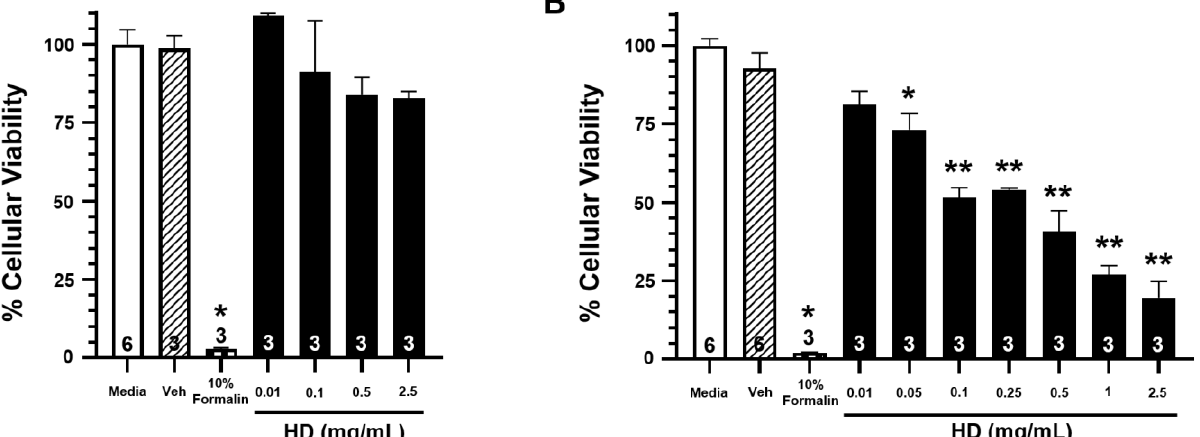
Figure 2. Effects of HD on the viability of EpiAirway TM tissues. Open bars represent mean ± SEM of cellular viability of untreated EpiAirway TM tissues at 3 h ( A ) or 24 h ( B ).Closed bars represent mean ± SEM of cellular viability of EpiAirway TM tissues at 3 h ( A ) or 24 h ( B ) following treatment with increasing concentrations of HD (0.01 – 2.5 mg/mL; 0.0629 – 15.7 mM). Cross-hatched bars represent mean ± SEM of cellular viability of EpiAirway TM tissues at 3 h ( A ) or 24 h ( B ) with an equivalent amount of vehicle (corn oil). Checkered bars represent mean ± SEM of cellular viability of EpiAir- way TM tissues treated with 10% formalin (positive control) at 3 h ( A ) or 24 h ( B ). Experimental n is indicated within each bar. * Significantly decreased compared to vehicle control at p < 0.05. ** Sig- nificantly decreased compared to vehicle control at p < 0.01. SEM indicates the standard error of the mean.